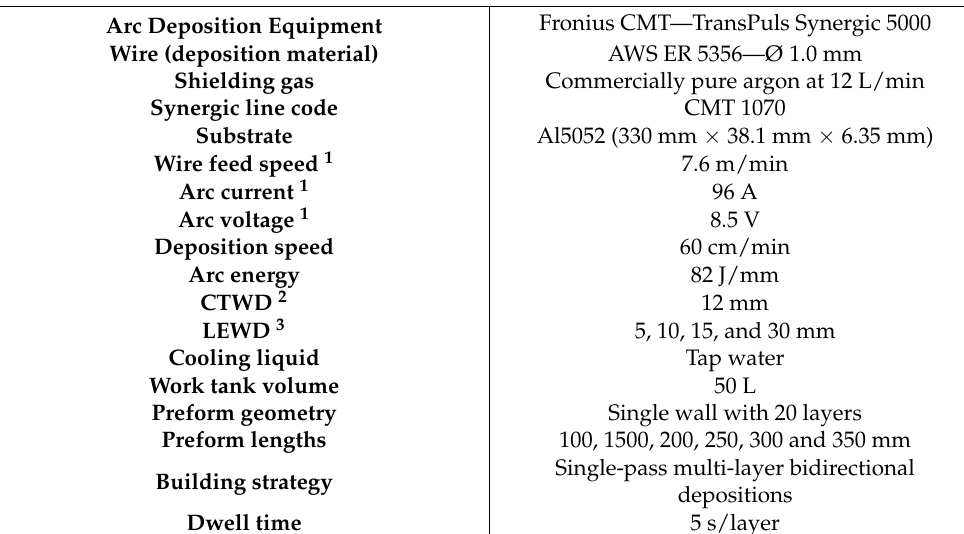
Table 2. Deposition conditions.